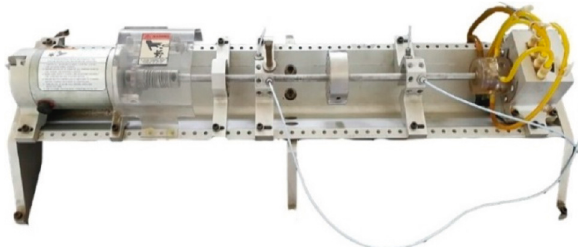
Figure 8: Bently-RK4 rotor vibration test